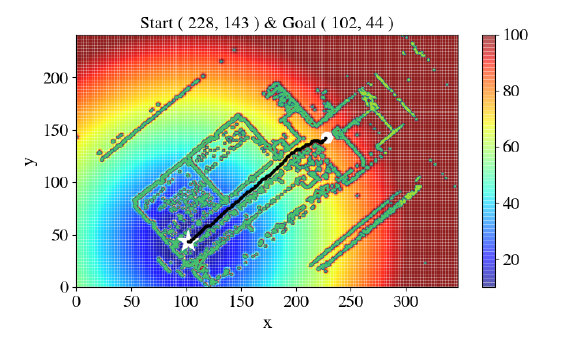
Figure 14. A feasible path is found from (228, 143) to (102, 44).